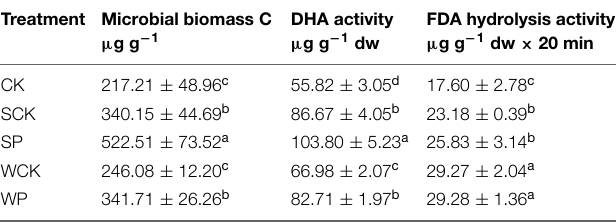
TABLE 4 | Microbial biomass C and soil enzyme activities after phytoremediation for 120 days. Treatment Microbial biomass C µ g g − 1